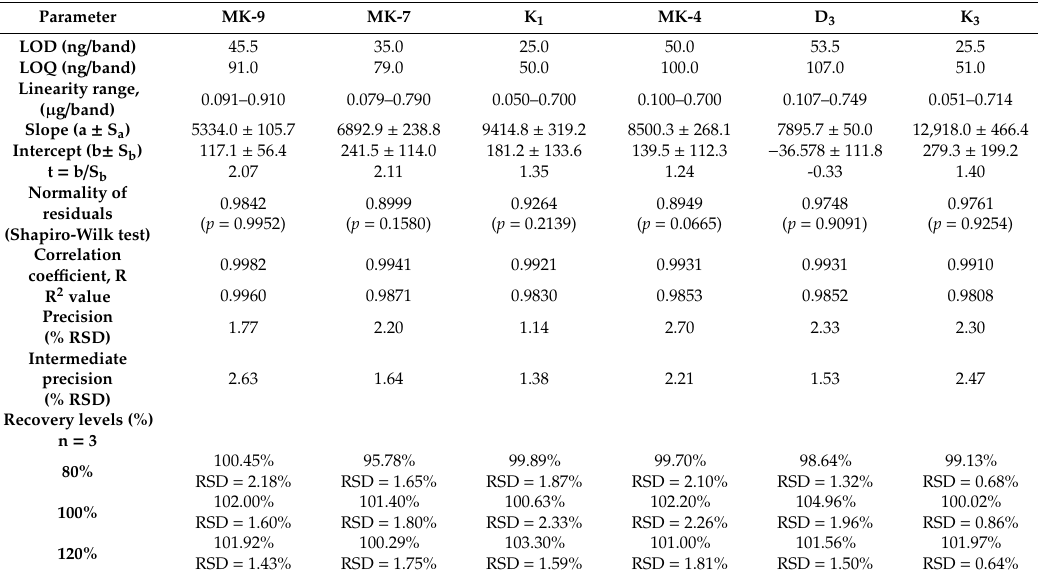
Table 2. Method validation